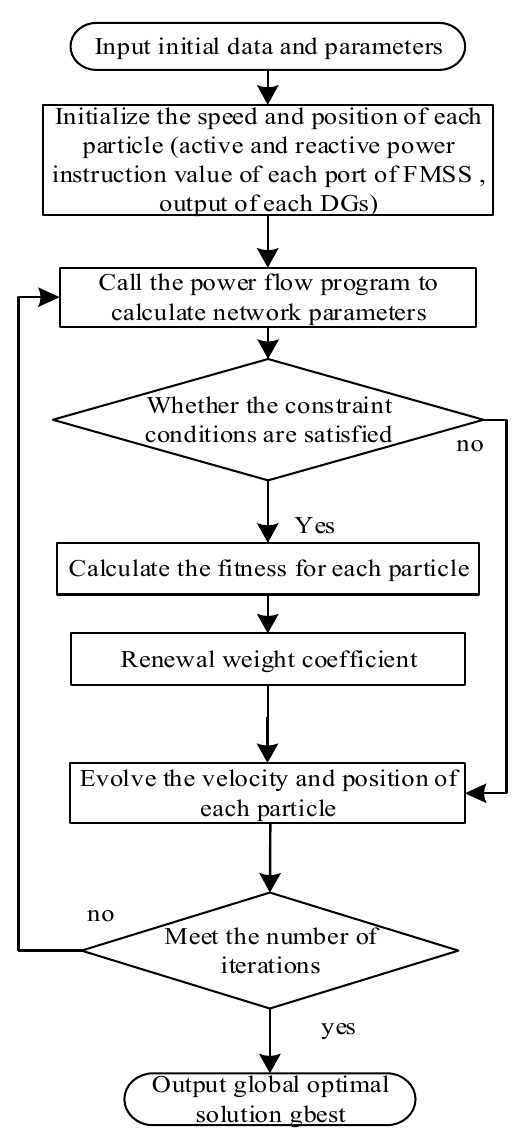
Figure 4. Flow chart of improved particle swarm optimization.